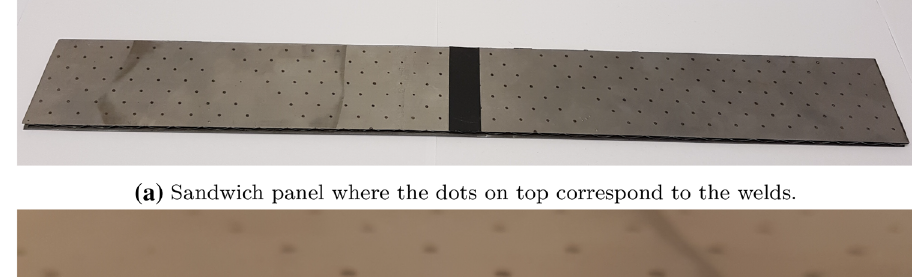
Fig. 3 Manufactured specimen of a Type A sandwich panel with bidirectionally corrugated